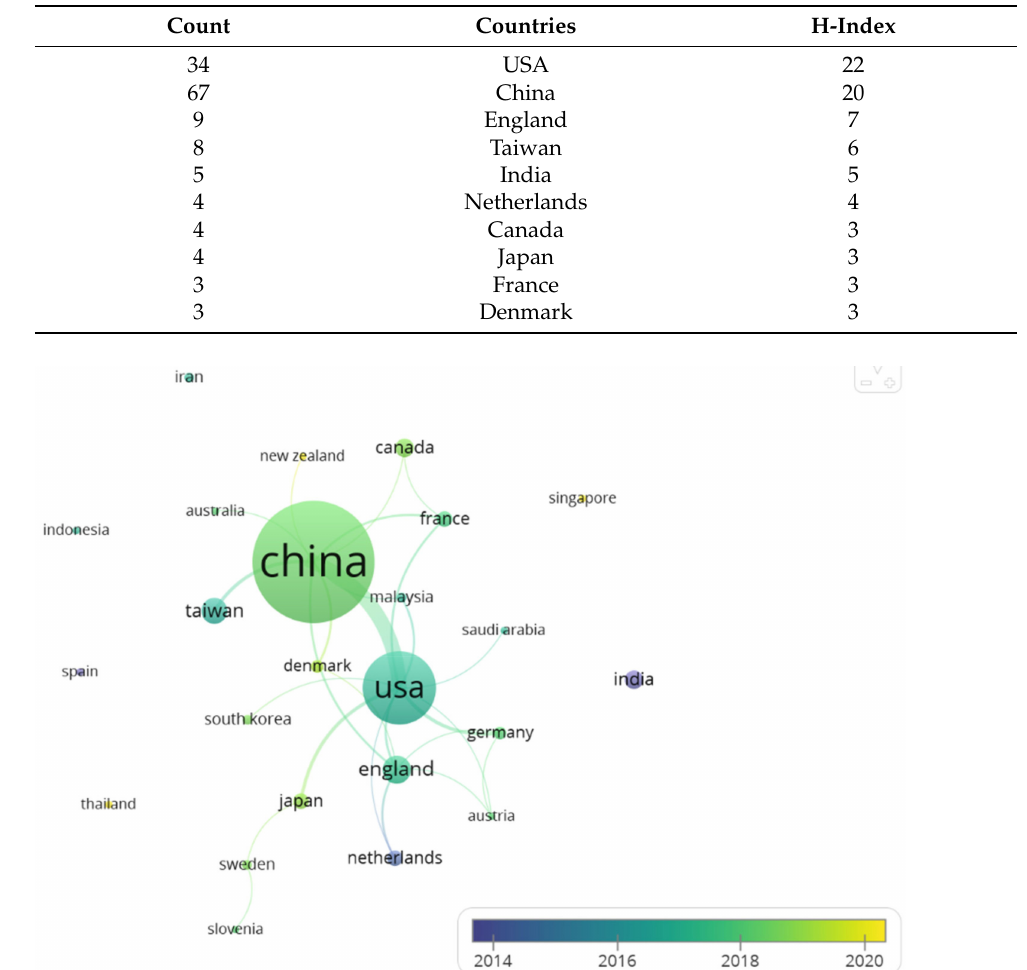
Table 3. The top 10 productive countries.